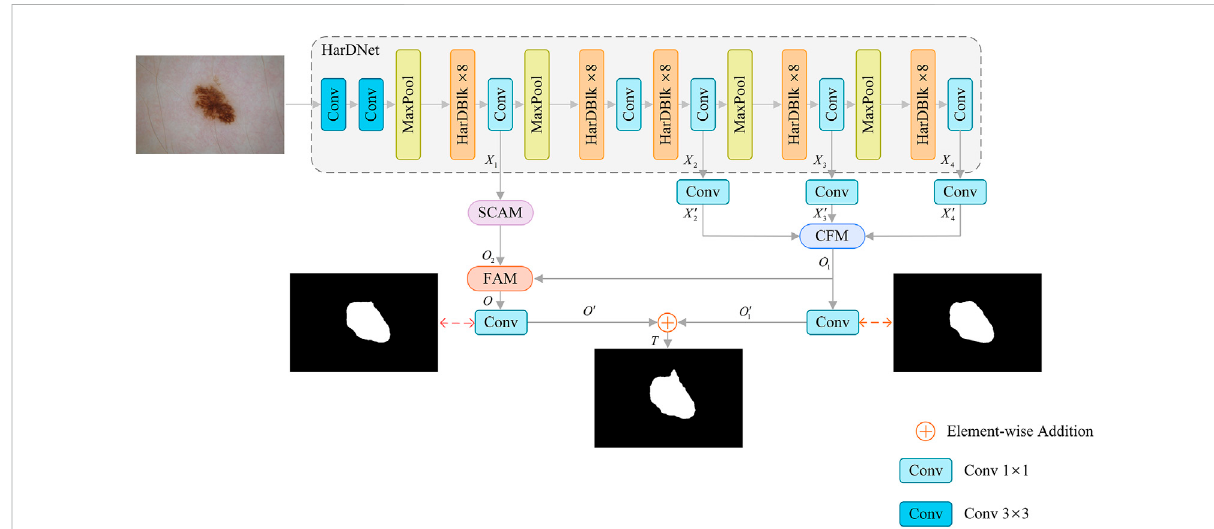
FIGURE 2 Framework of our SL-HarDNet, which consists of four parts: HarDNet backbone network, cascaded fusion module (CFM), spatial channel attention module (SCAM), feature aggregation module (FAM). HarDNet backbone is used as the encoder. CFM aggregates different scale features. SCAM obtains key location information. FAM fuses high-level and low-level